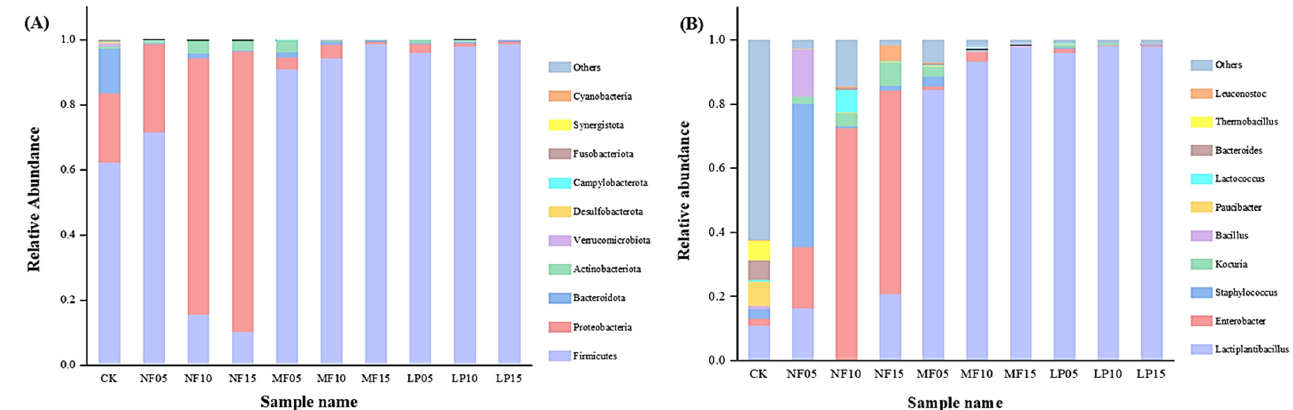
Figure 3. Changes in relative abundance of the microbial community of different Suanyu samples at the phylum level ( A ) and at the genus level ( B ). CK, 0 day fermentation samples; NF, natural fermentation; LP, inoculated L. plantarum ; MF, inoculated L. plantarum combined with S. cerevisiae